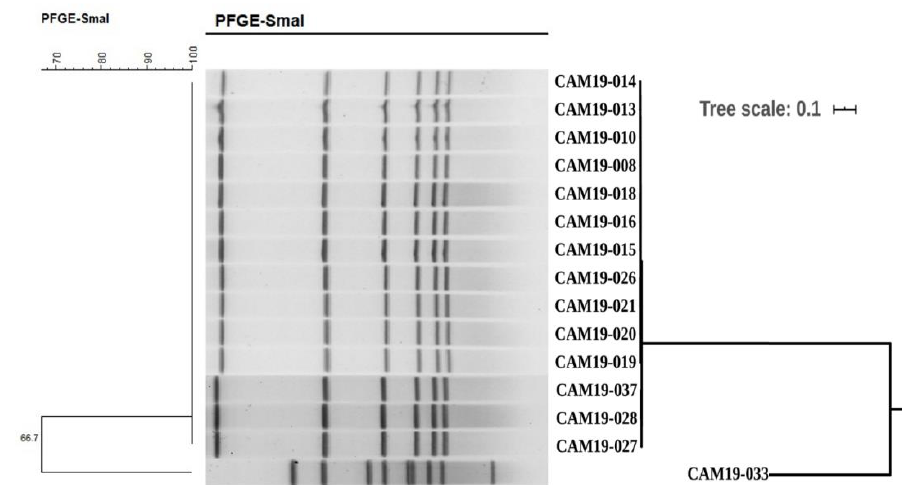
Figure 1. PFGE dendrogram and phylogenomic SNPs tree of the fifteen strains of C. jejuni . The PFGE- Sma I enzyme digestion patterns are shown on the left and the middle. The phylogenomic SNPs tree of the fifteen strains of C. jejuni is shown on the right with a scale bar at 0.1.